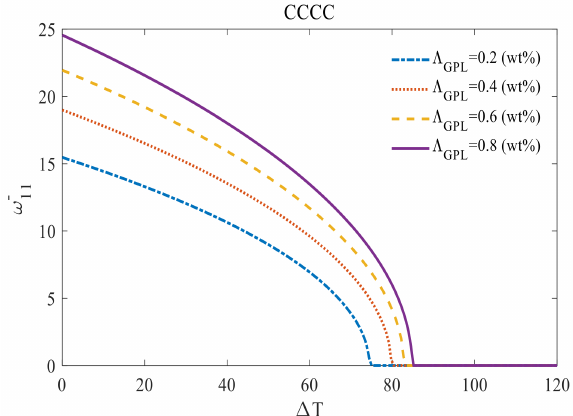
= 0.3% ) : ( a ) CCCC boundary conditions, ( b ) SSSS boundary conditions. ( b / a = 1, a / h = 25, ∆ GPL